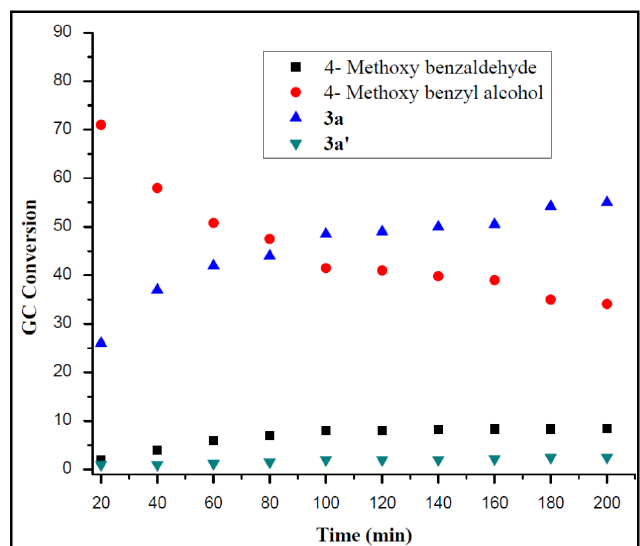
Figure 1. Plot of [ 2a ] vs time.